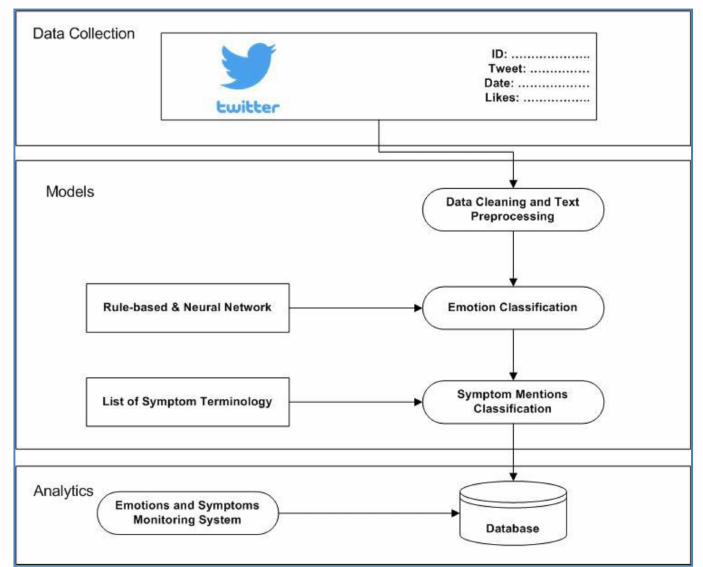
Figure 1. Emotions and Symptoms Monitoring